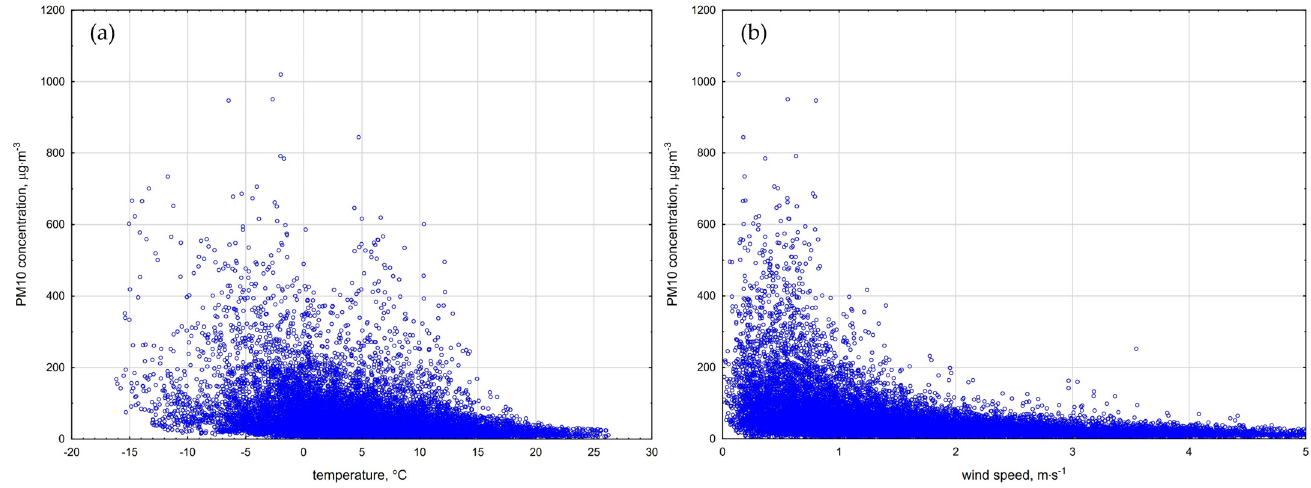
Figure 5. Changes in PM10 concentration depending on the ( a ) air temperature and ( b ) wind speed that occurred in the 2018 heating season in Rybnik .